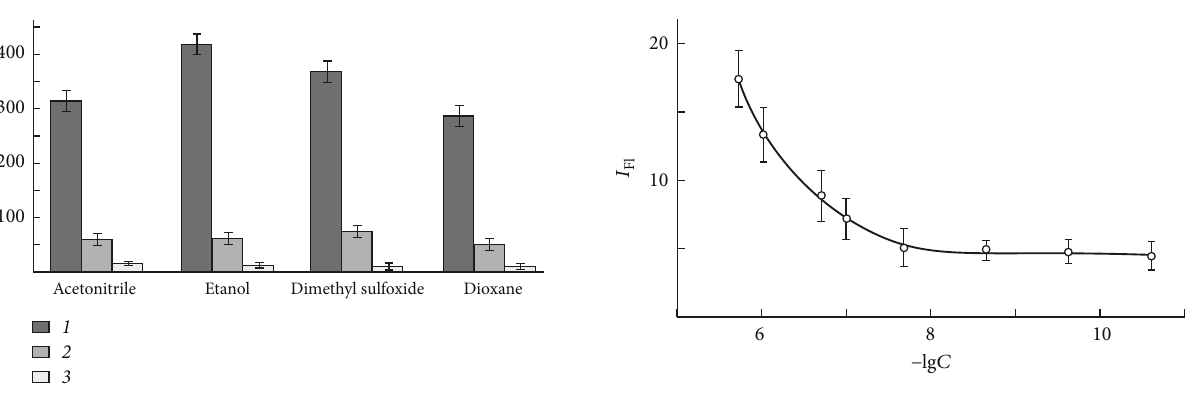
Figure 2: The fluorescence intensity ( 𝐼 Fl ) of pyrene on the CDA matrix when sorbed from aqueous media with concentrations of 2 ⋅ 10 −4 g/L ( 1 ), 2 ⋅ 10 −5 g/L ( 2 ), and 2 ⋅ 10 −6 g/L ( 3 ), containing various organic solvents: acetonitrile, ethanol, dimethyl sulfoxide, and dioxane. 𝐼 Fl is measured at 𝜆 em = 394 nm, 𝜆 ex = 320 nm.